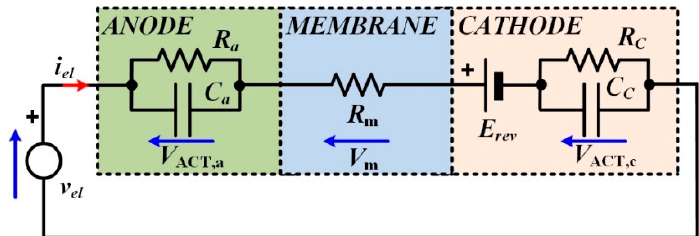
Figure 4. PEM electrolyzer equivalent electrical circuit.